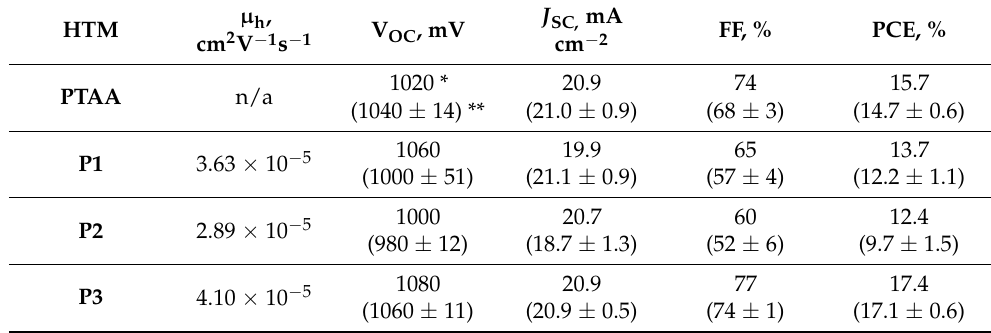
Figure 4. J -V curves of PSCs fabricated under optimized conditions ( a ); steady-state PL spectra for glass/perovskite/HTM stacks ( b ); time-resolved PL measurements of the perovskite films deposited on the P1 – P3 HTMs ( c ). Table 2. Hole mobilities of P1 – P3 and photovoltaic performance of PSCs based on P1 –